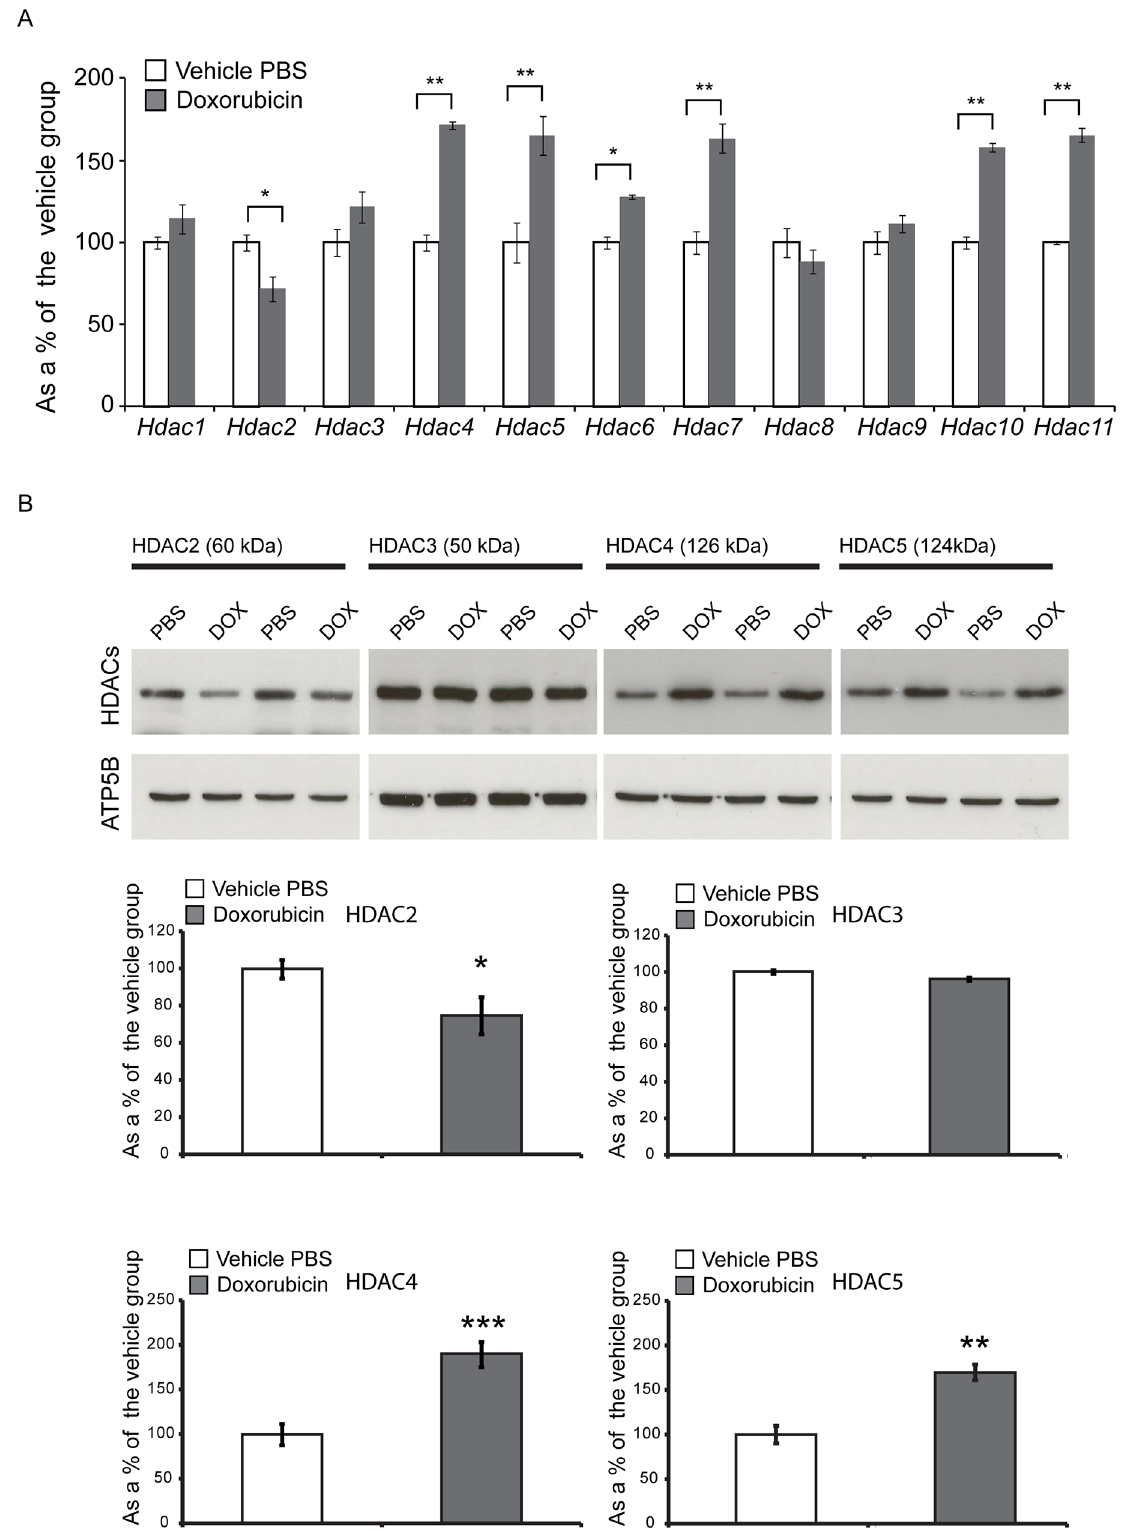
Fig 4. Chronic administration of doxorubicin leads to a significant transcriptional deregulation of Hdacs . (A) Transcript levels of Hdac4 , Hdac5 , Hdac6 , Hdac7 , Hdac10 and Hdac11 were increased, while Hdac2 mRNA was significantly reduced, in